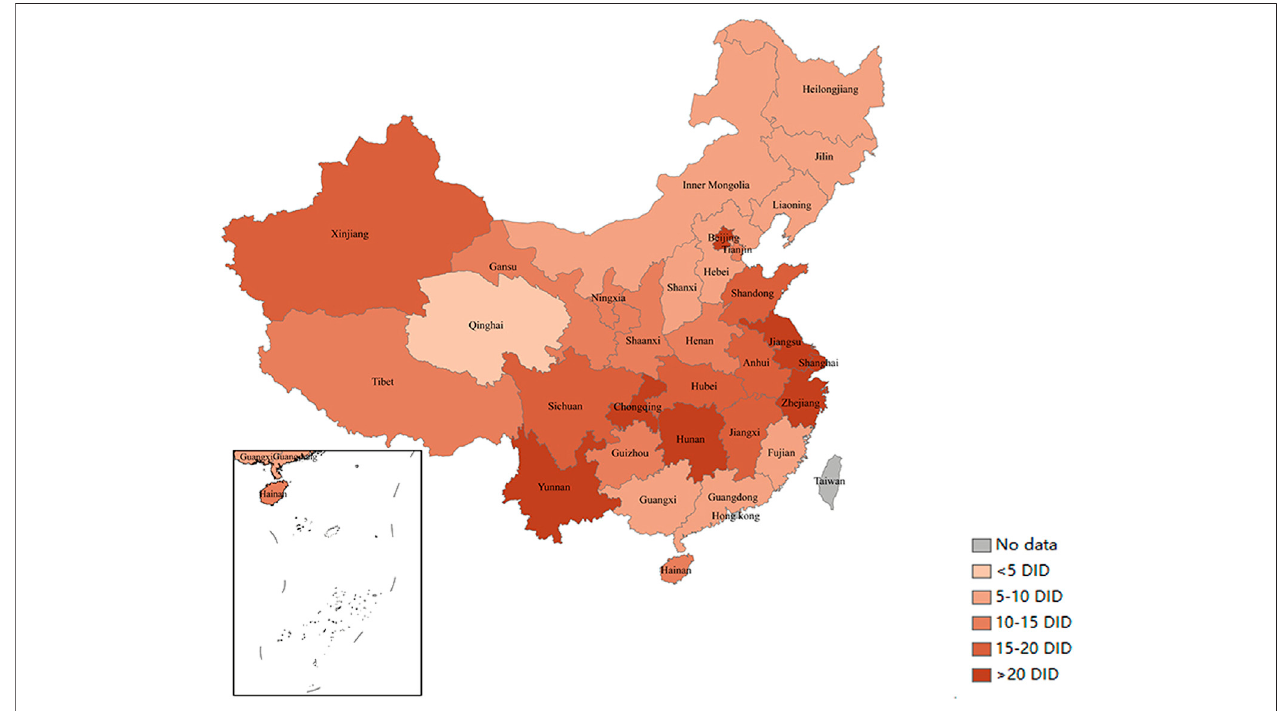
FIGURE 1 | Antibiotic consumption (expressed in DID) in China ’ s public medical institutions in 2019. Note: Data of 31 provinces were involved. DID, de fi ned daily doses per 1,000 inhabitants per day.